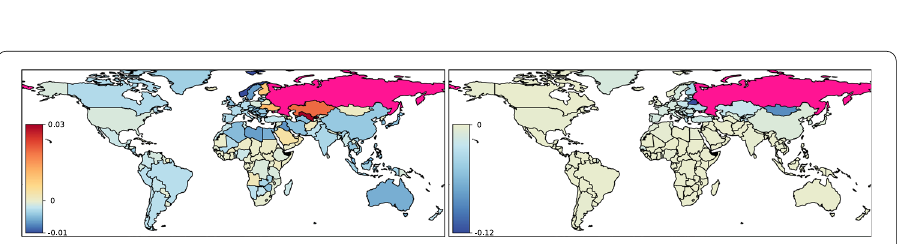
Fig. 6 Sensitivity of country balance. Sensitivity of country balance dB c / d δ cs for product price s = 3 (mineral fuels) of Russia. Left panel: probabilities are computed from PageRank and CheiRank vectors; Right panel: probabilities are computed from the trade volume of Export–Import. Data are shown for year 2018. Sensitivity values for Russia are dB c / d δ cs = 0.13 (left panel) and 0.24 (right panel); these values are marked by separate magenta color to highlight sensitivity of other countries in a better